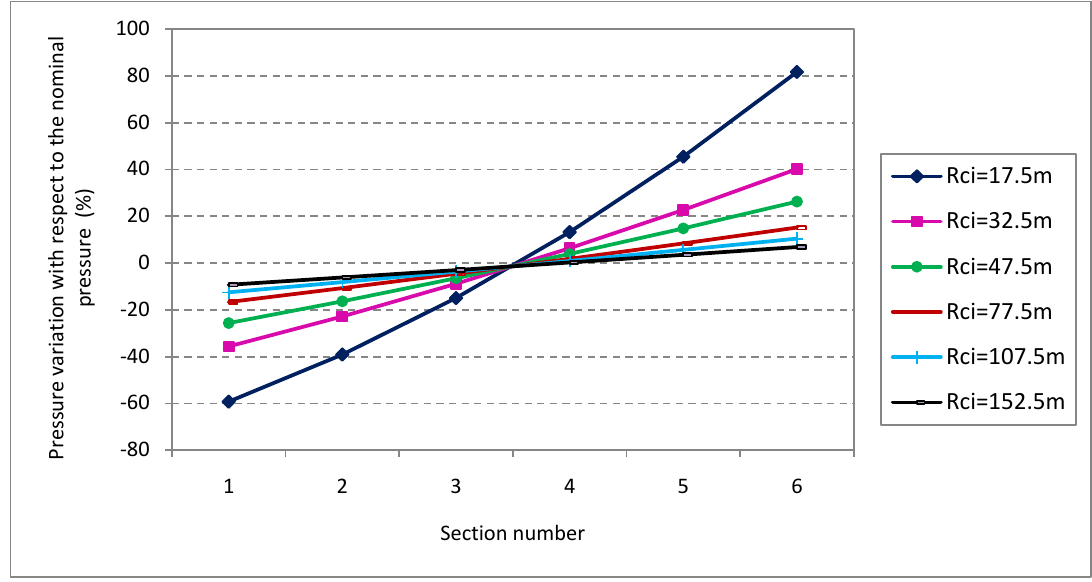
Figure 8. Percentage of pressure variation with respect to the nominal pressure considering the pressure regulation of each one of the 6 sections (5 nozzles per section) of a 14.5 m boom to obtain an uniform surface dose. Data have been obtained considering a 14.5 m boom sprayer carrying out treatment in circular trajectories in a circular plot with a 160 m— in radius at a displacement velocity of 7 km/h, and a nominal pressure of 2 bar (nozzle flow of 1.4